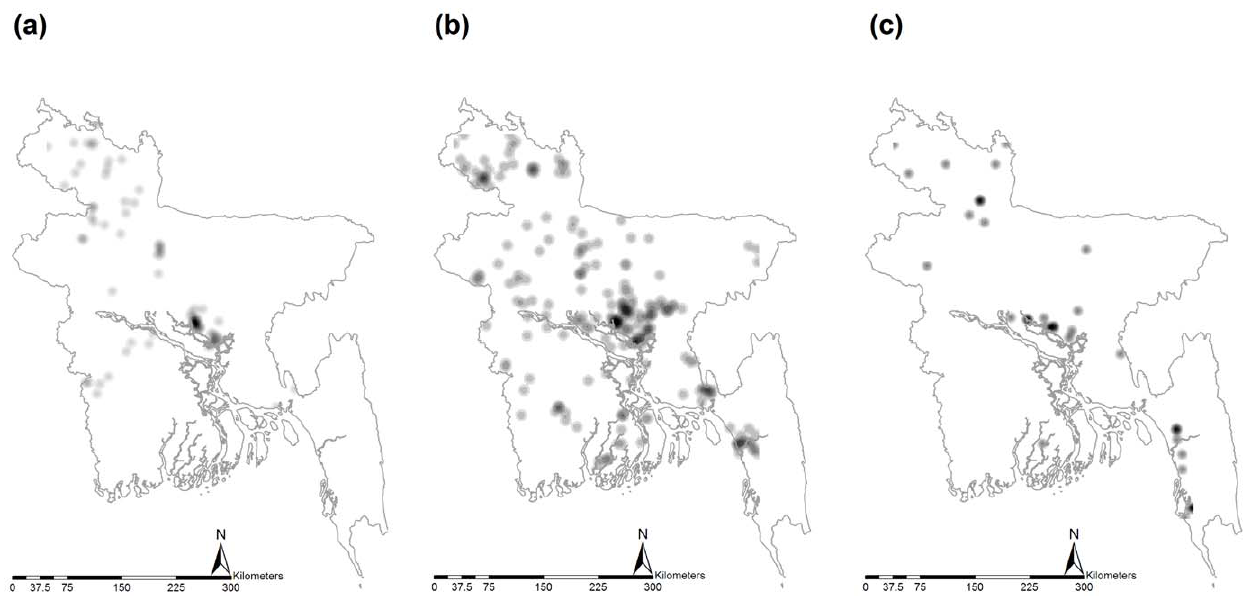
Figure 3. Kernel density estimation of spatial distribution of HPAI-H5N1 in poultry flocks in Bangladesh from 2007 through 2009: (a) first wave (b) second wave (c) third wave. A darker area corresponds to higher density.